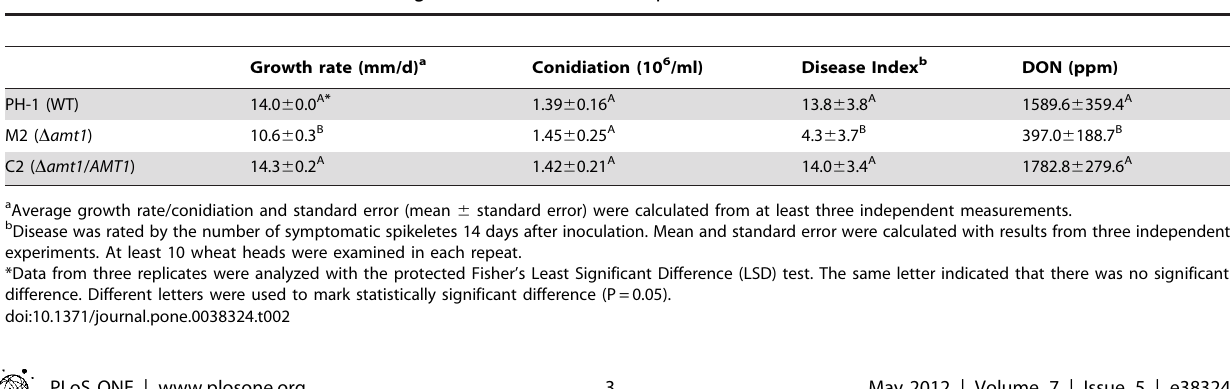
Table 2. Defects of the D amt1 mutant in growth, conidiation, and plant infection.